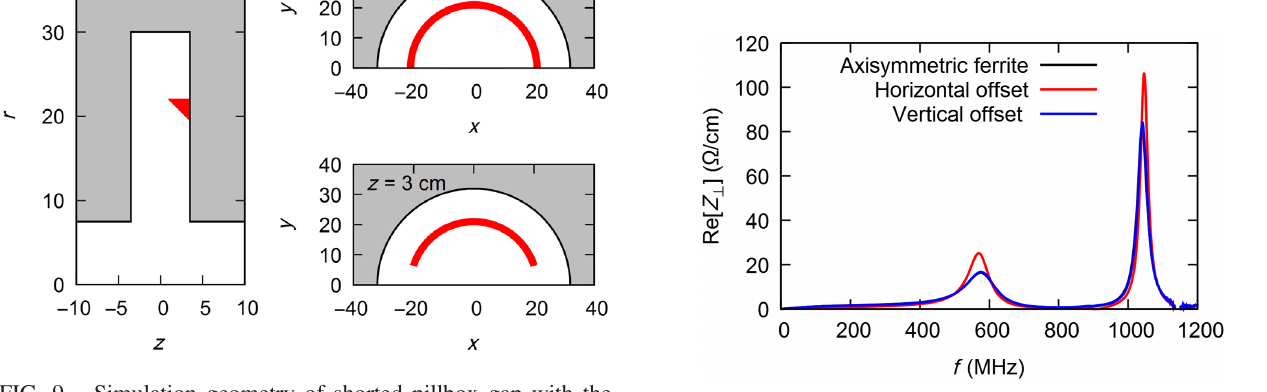
FIG. 10. Z ⊥ as a function of frequency for pillbox with ferrite. Black: axisymmetric ferrite ring. Red: ferrite arc with horizontal ( x ) offset of the beam, and Blue: vertical ( y )